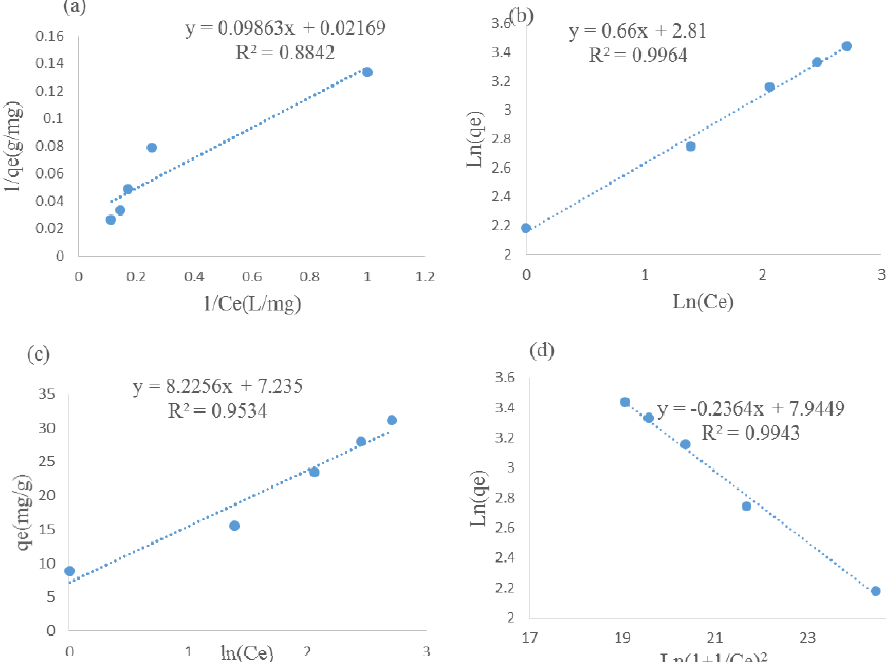
Fig. 4. Plots of isotherm models (a) Langmuir adsorption isotherm, (b) Freundlich adsorption isotherm, (c) Temkin adsorption isotherm and (d) Dobinin-Rodushkvich isotherm Fig. 4 Plots of isotherm models (a) Langmuir adsorption isotherm, (b) Freundlich adsorption Fig. 4 Plots of isotherm models (a) Langmuir adsorption isotherm, (b) Freundlich adsorption Fig. 4 Plots of isotherm models (a) Langmuir adsorption isotherm, (b) Freundlich adsorption Table 5. Isotherm constant parameters and correlation coefficients calculated for Table 5 Isotherm constant parameters and correlation coefficients calculated for adsorption of Pb +2 onto Fe 3 O 4 @MCM-41-NH 2. isotherm, (c) Temkin adsorption isotherm and (d) Dobinin-Rodushkvich isotherm. Fig. 4 Plots of isotherm models (a) Langmuir adsorption isotherm, (b) Freundlich adsorption isotherm, (c) Temkin adsorption isotherm and (d) Dobinin-Rodushkvich isotherm. adsorption of Pb +2 onto Fe O @MCM-41-NH isotherm, (c) Temkin adsorption isotherm and (d) Dobinin-Rodushkvich isotherm. isotherm, (c) Temkin adsorption isotherm and (d) Dobinin-Rodushkvich 3 4 2 Isotherm Parameters Value of parameter q m (mg.g -1 ) 46.08 Longmuir K L (L.mg -1 )